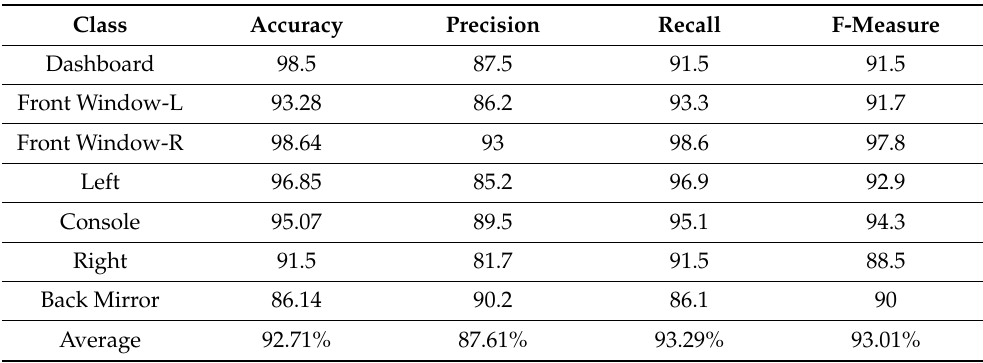
Table 5. Detail percentage by class of various driver